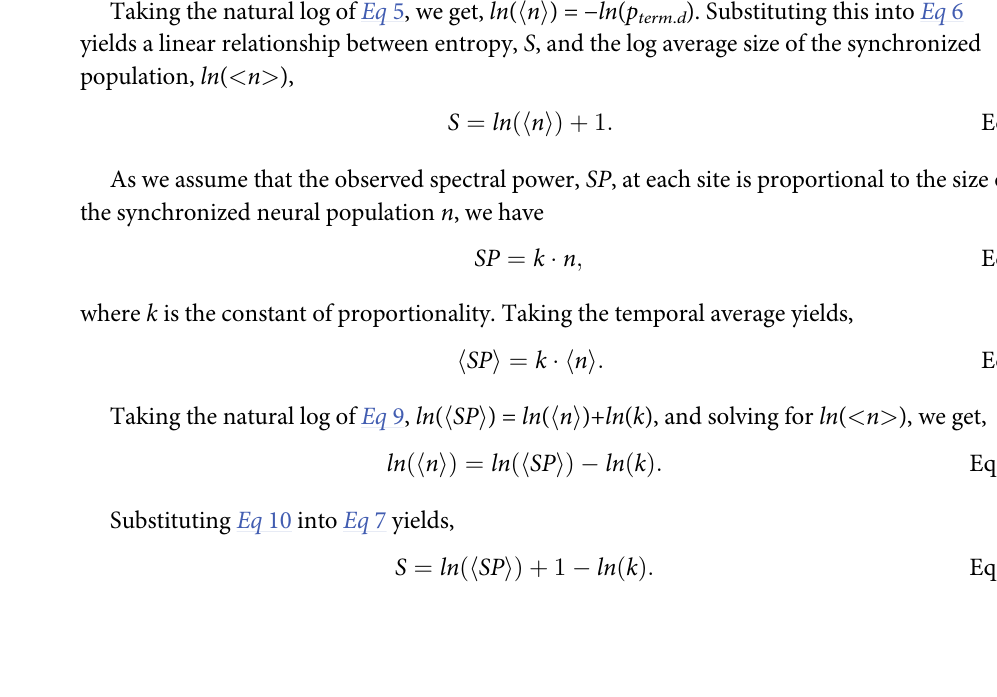
substituted for p . Note that even if p varied term . d term term . d term . d ). Substituting this into Eq 6 term . d